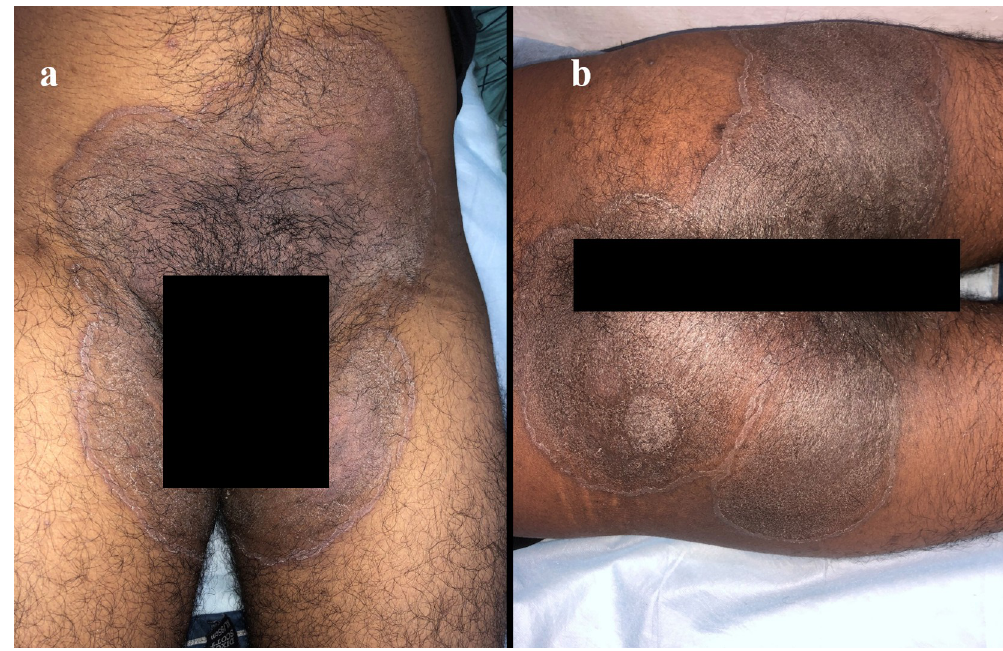
Fig 1. Annular plaques with raised edges and scaly central region over groins (a) and buttocks (b). Note the prominent pigmentation, a common feature seen in T . indotineae infections in Indian patients.